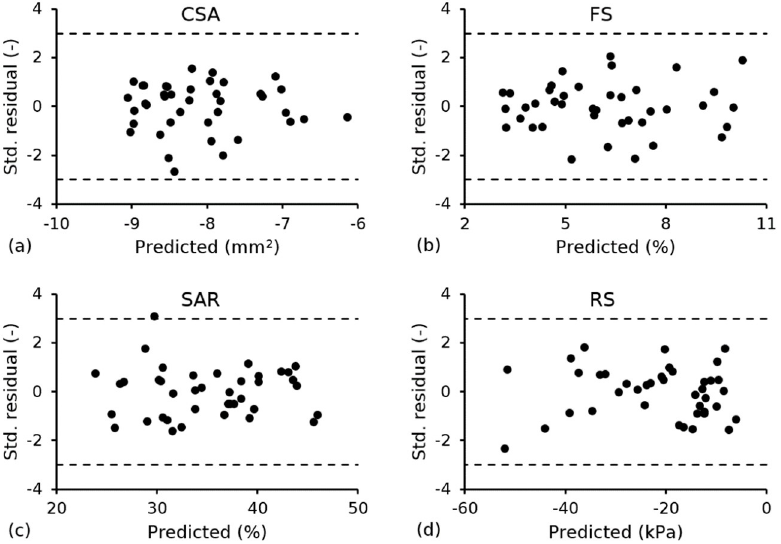
Fig 6. Standardised residual vs . predicted response using the statistical model in Eq 16 for (a) CSA ; (b) FS ; (c) SAR and (d) RCP .